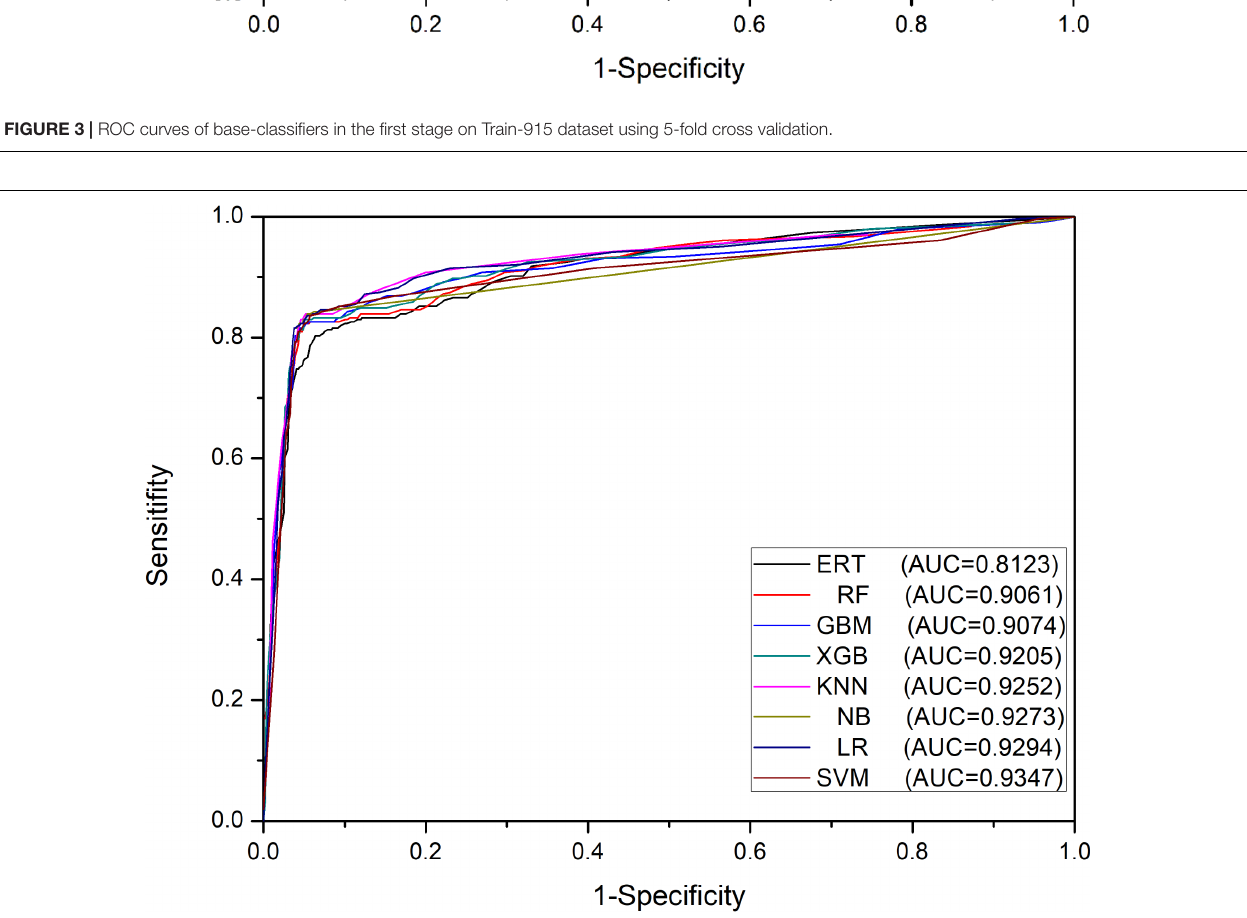
FIGURE 4 | ROC curves of meta-classifiers in the second stage on Train-915 dataset using 5-fold cross validation.